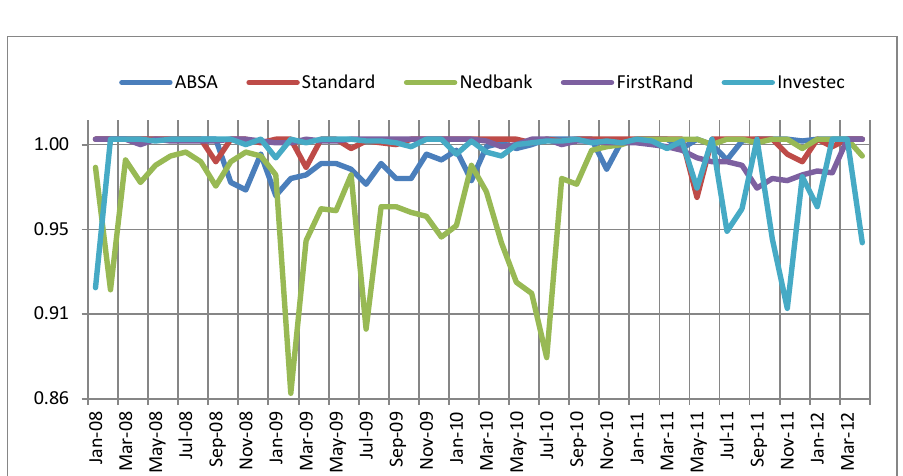
FIGURE 5: Comparison in terms of scale efficiency (output-orientated)